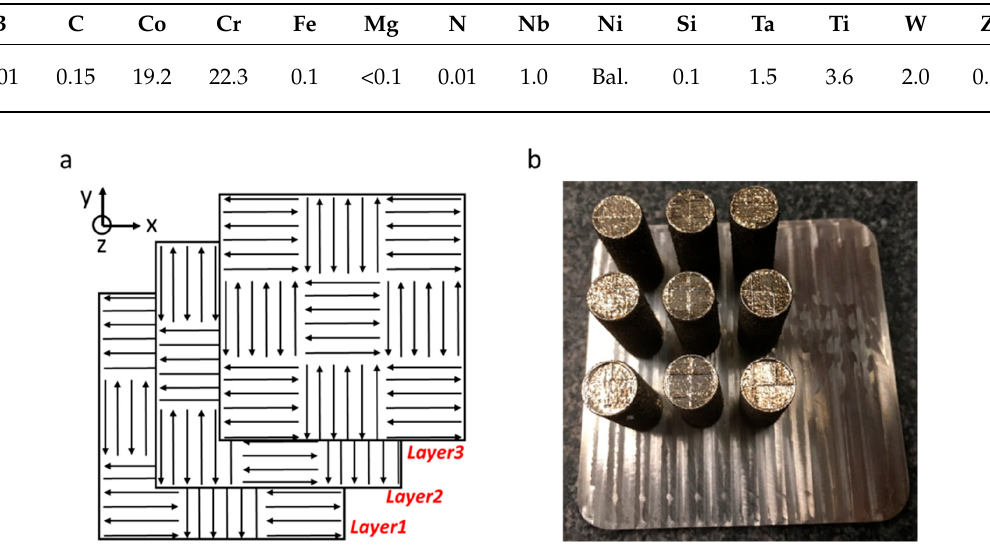
Figure 1. ( a ) Schematic of island laser scan strategy; ( b ) image of the LPBF Inconel 939 samples. Table 1. Elemental composition of Inconel 939 powders.